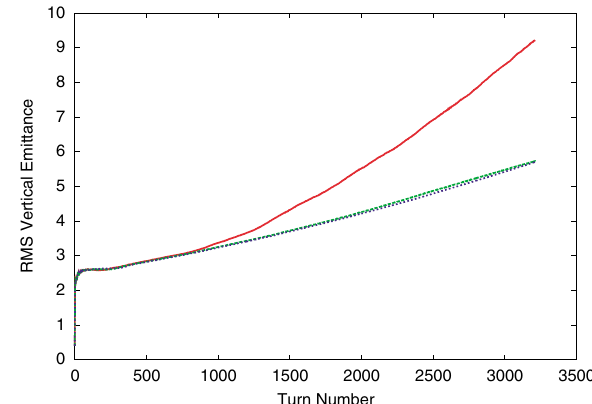
FIG. 3. (Color) Experimental vertical beam profiles after the accumulation of the full intensity PSR beam (red solid curve), the half intensity beam (blue dotted curve), and the quarter intensity beam (pink dashed curve). The three profiles have been normalized to give identical areas under the